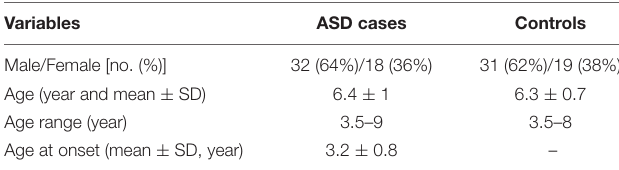
TABLE 2 | Demographic data of ASD children and controls.